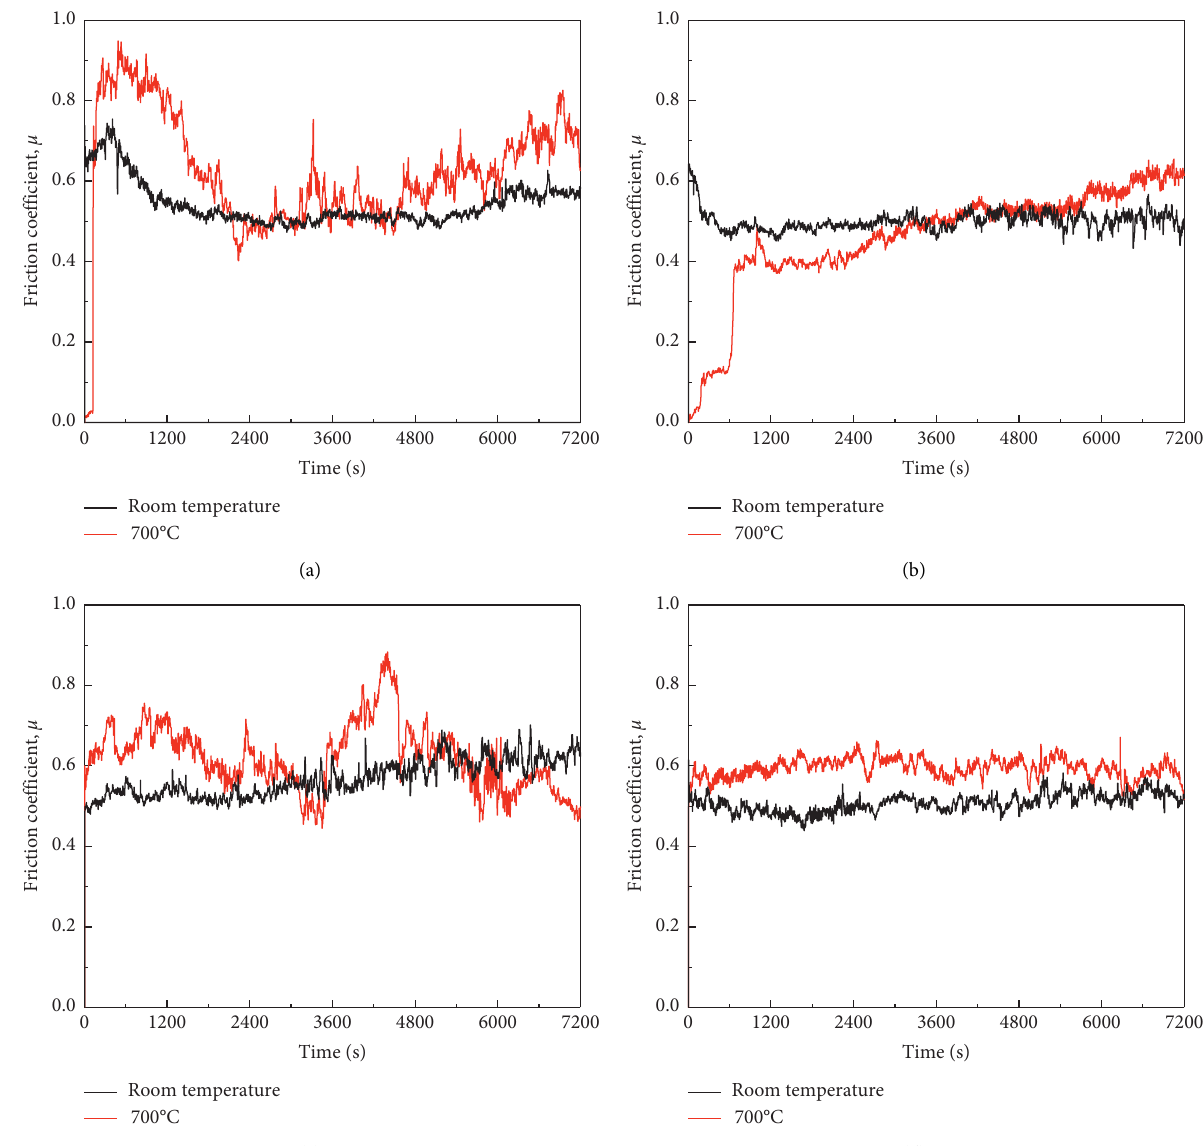
Figure 17: Friction coefficient vs. time curves of H13 steel and coatings at room temperature and 700 ° C: (a) H13 steel; (b) S0 coating; (c) S1 coating; (d) S2